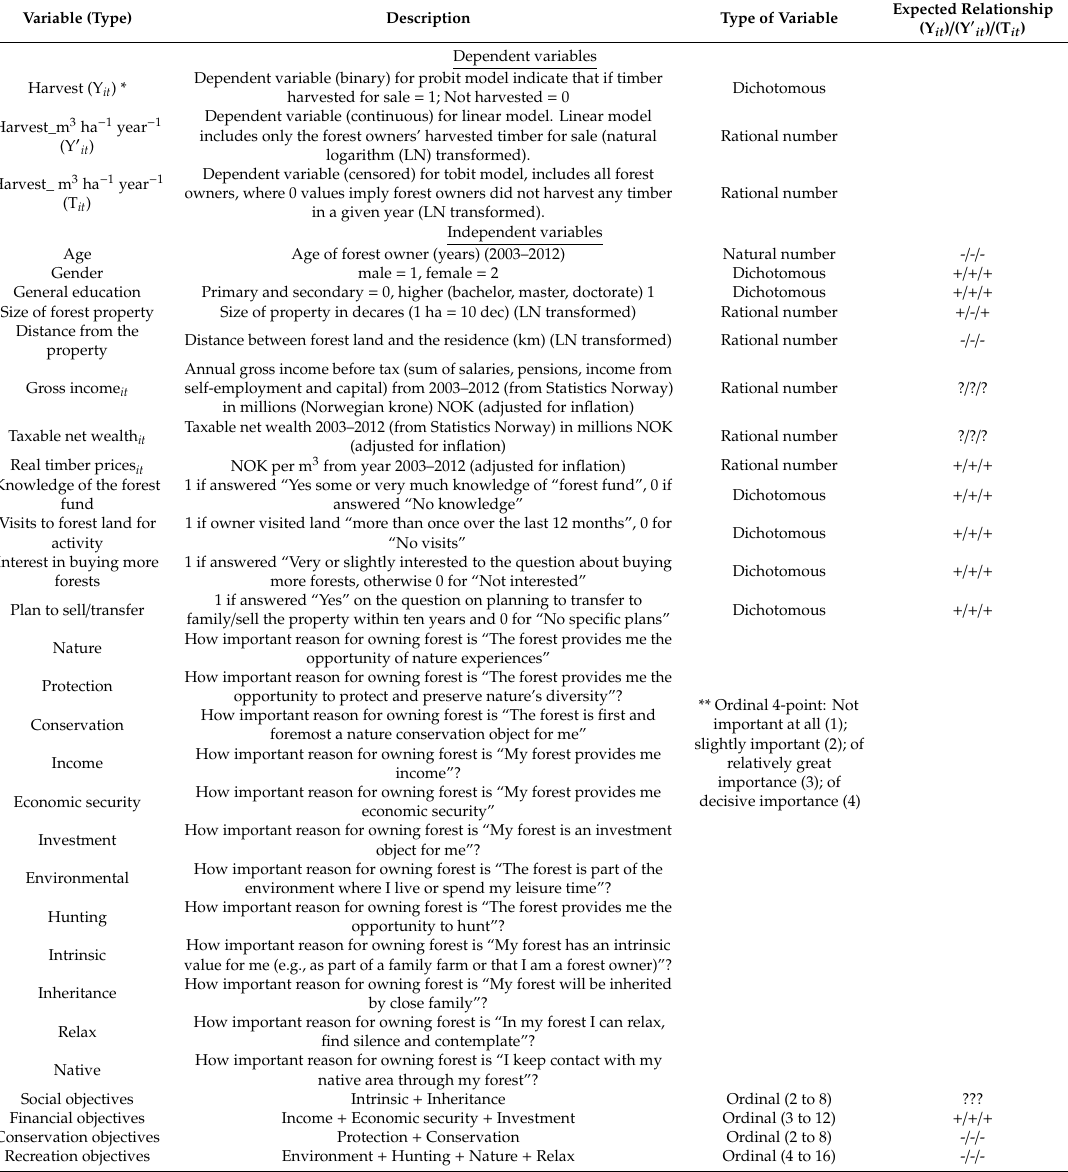
Table 1. Description of variables (dependent and independent; type of variable) and expected relationship used in the empirical models examining non-industrial private forest owners’ decision to harvest timber in